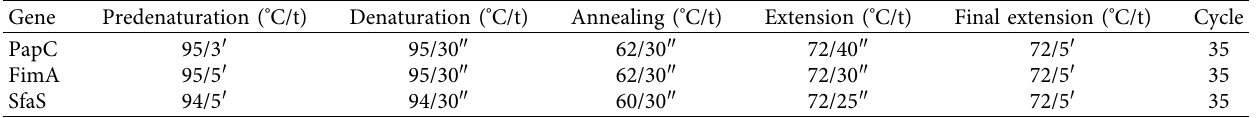
Table 1: Temperature of the PCR condition.